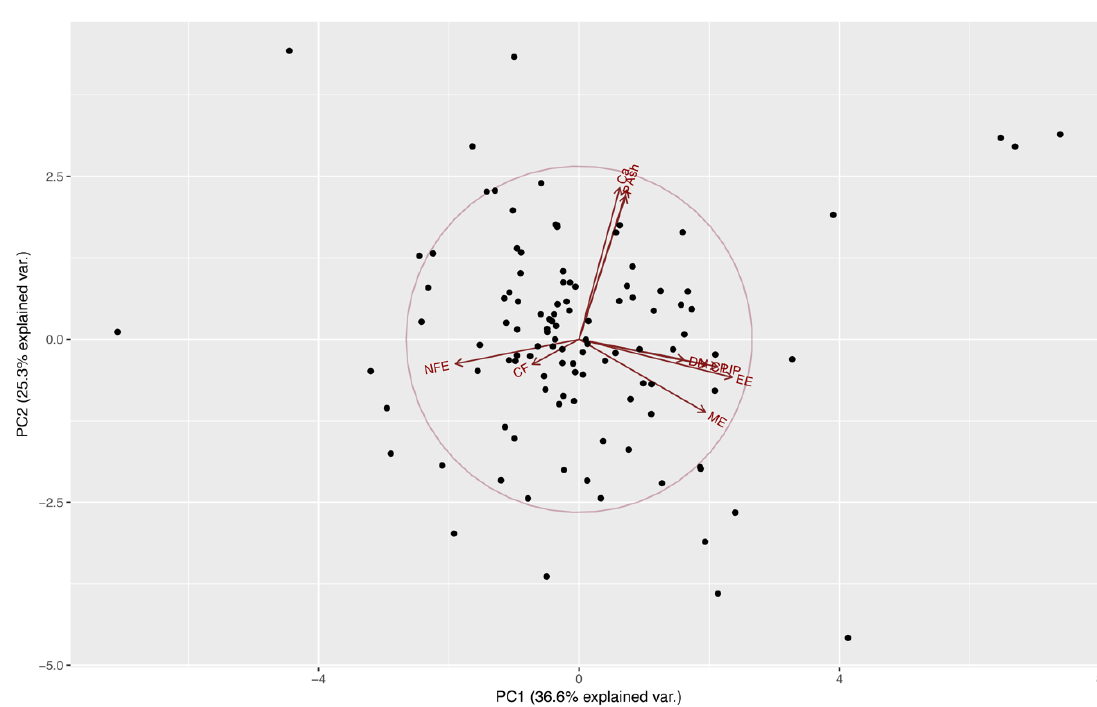
1 Principal component (PC), dry matter (DM), crude protein (CP), crude fiber (CF), ether extract (EE), nitrogen-free extract (NFE), ash, calcium (Ca), phosphorus (P), total lipids (LIP), metabolizable energy (ME), standard deviation (SD).